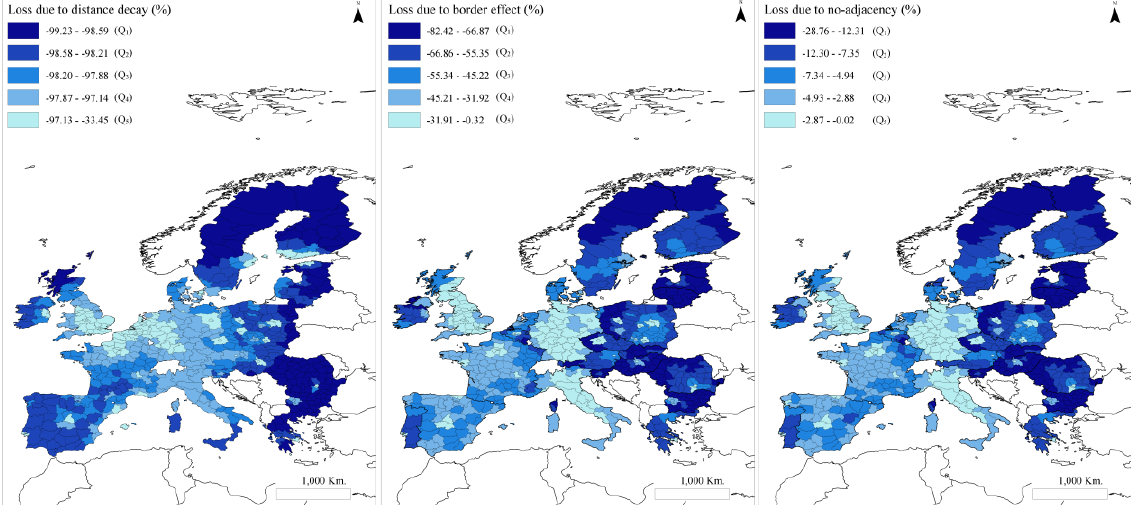
Figure 3. Difference in market potential results after introducing subsequent control variables, as a